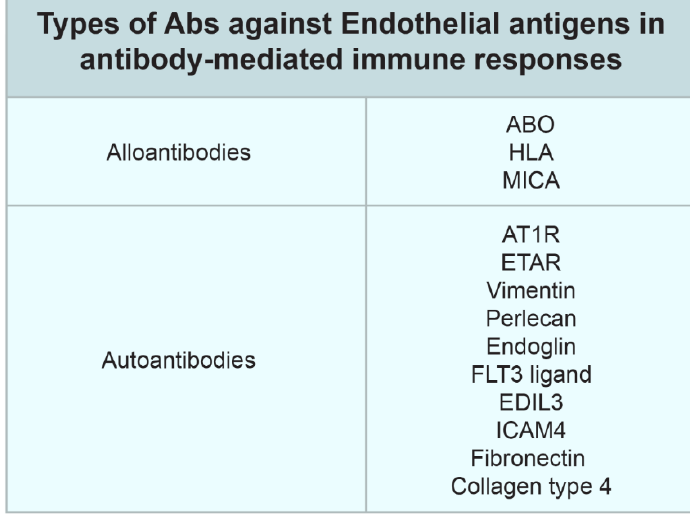
Figure 1. Post-transplant antibodies against human leukocyte antigen (HLA) and non-HLA antigens [68,78,86–92]. Abbreviations: human leukocyte antigen (HLA), major histocompatibility complex class I related chain A antigen (MICA); angiotensin type 1 receptor (AT1R); endothelin-1 type A receptor (Anti-ETAR); FMS-like tyrosine kinase 3 (FLT3); Epidermal growth factor-like repeats and discoidin I-like domain 3 (EDIL3); Intercellular adhesion molecule 4 (ICAM4) .